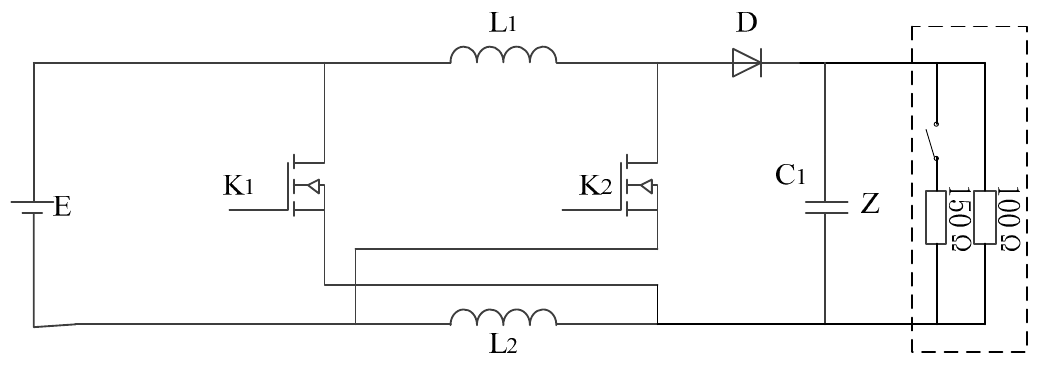
Figure 16. Schematic diagram of load disturbance experiment.